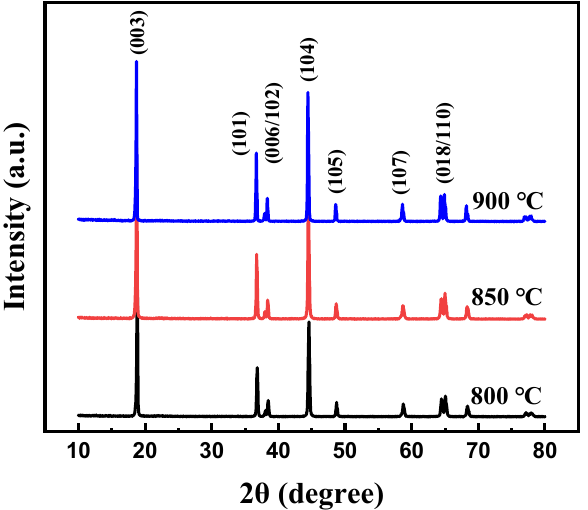
Figure 1. XRD patterns of Li[Ni 0.6 Co 0.2 Mn 0.2 ] 0.98 Ga 0.02 O 2 calcinated at different temperatures.